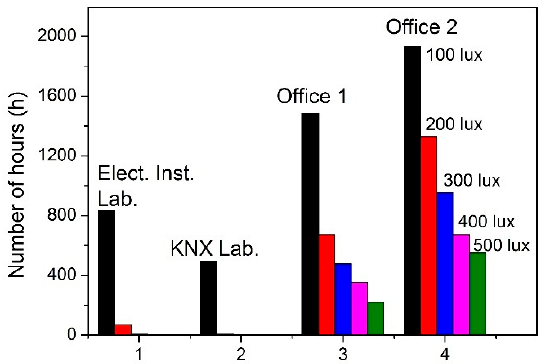
Figure 11. Number of hours from 1 July 2014 to 30 April 2015 with illuminance level higher than specified values.